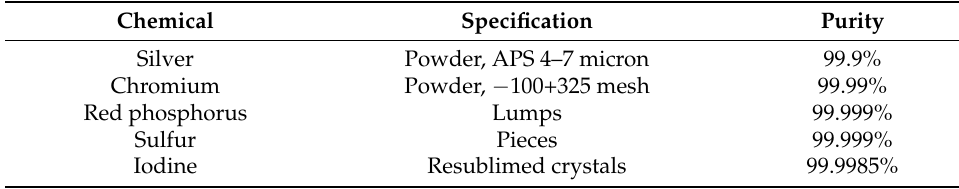
Table 1. Elemental educts used for the CVT growth of AgCrP 2 S 6